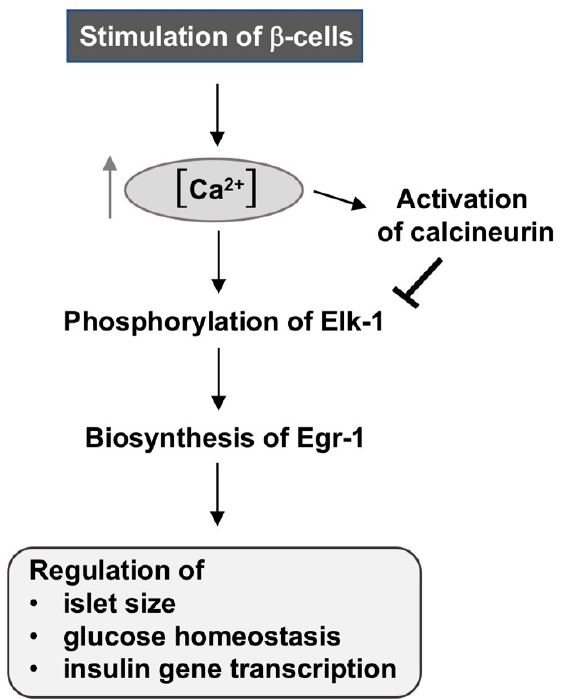
Figure 7. Sequential interplay of Elk-1, Egr-1, and calcineurin to regulate islet size and glucose homeostasis. Increase in intracellular Ca 2+ ion concentration triggers phosphorylation of Elk-1 by Ca 2+ -responsive protein kinases. Elk-1 binds to different sites of the Egr-1 promoter and induces transcription of the Egr-1 gene. The newly synthesized Egr-1 protein regulates the formation of islets of sufficient size and thus glucose homeostasis. Calcineurin is activated by higher Ca 2+ ion concentrations in cells and catalyzes dephosphorylation and inactivation of Elk-1.